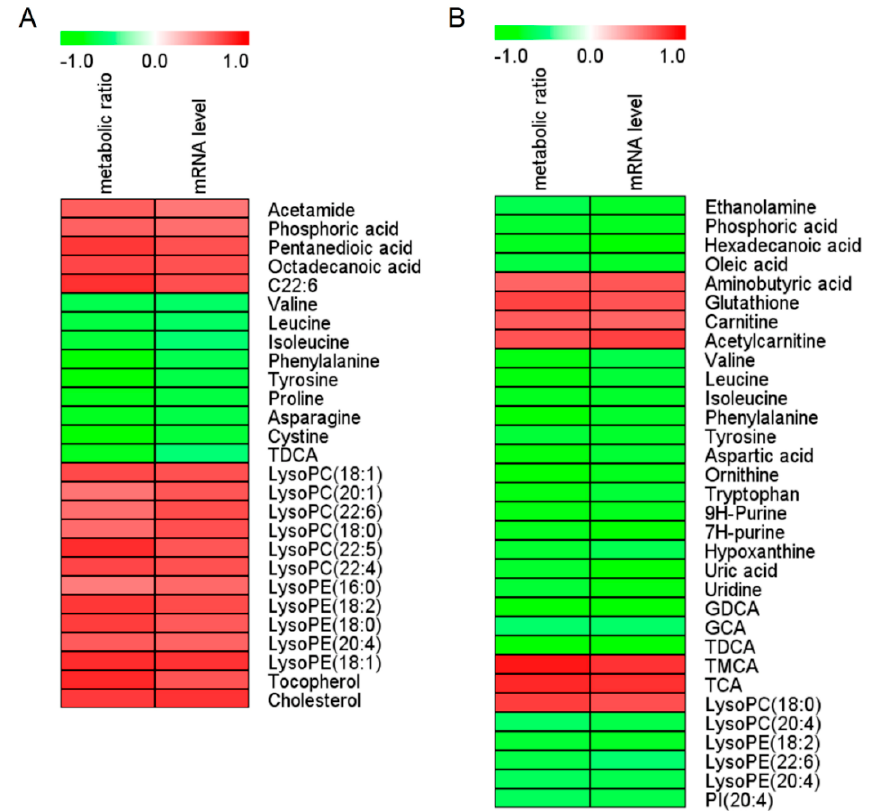
Figure 2. Spearman correlation analysis of serum ( A ) and liver ( B ) marker metabolites induced by β -naphthoflavone as well as the metabolic ratio and mRNA level of CYP1A2. Green squares indicate significant negative correlations ( − 0.51 to − 0.90 for serum, − 0.53 to − 0.89 for liver; p < 0.05), white squares indicate non-applicable correlations, and red squares indicate significant positive correlations (0.52 to 0.83 for serum, 0.61 to 0.89 for liver; p < 0.05). The metabolic ratio is AUC 0-12 h of paracetamol / AUC 0–12h of phenacetin. AUC 0–12h is the area under the plasma concentration–time curve from 0 to 12 h. The value of the metabolic ratio reflects CYP1A2 activity, and a higher value represents greater activity. The CYP1A2 mRNA level was calculated using the 2 - ∆ Ct method. Ct : cycle threshold; △ Ct = Ct of CYP1a2 - Ct of β -actin ; C22:6: cis-4,7,10,13,16,19-docosahexaenoic acid; GCA: glycocholic